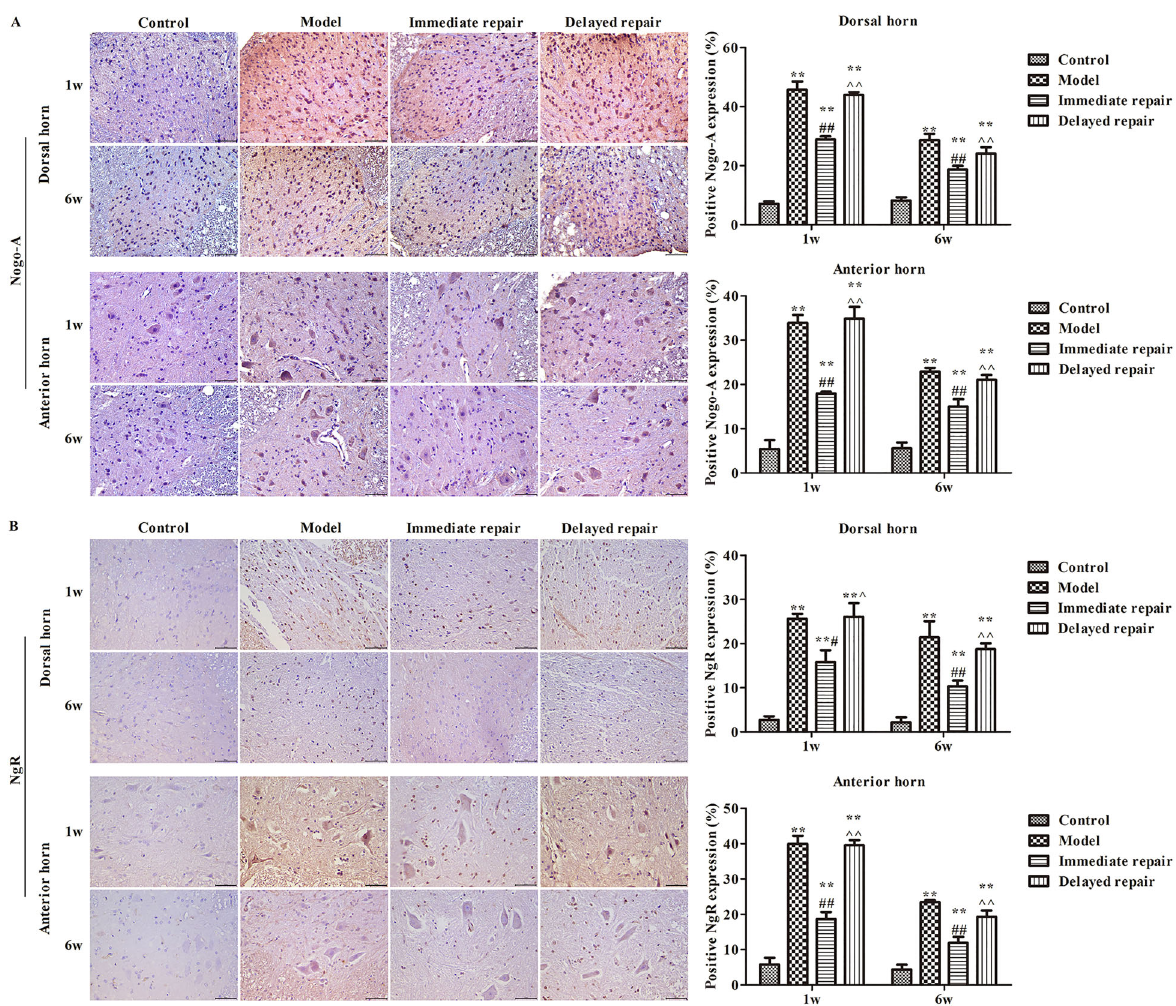
Figure 3. The expression of Nogo-A ( A ) and NgR ( B ) in the anterior horn and posterior horn of the spinal cord after sciatic nerve injury in rats of different groups was detected by immunohistochemistry. Magni fi cation 400 (cid:1) , scale bar 50 m m. The data are reported as means ± SD. **P o 0.01, compared with control group; # P o 0.05, ## P o 0.01 compared with model group; ^ P o 0.05, ^^ P o 0.01 compared to immediate repair group (ANOVA followed by LSD